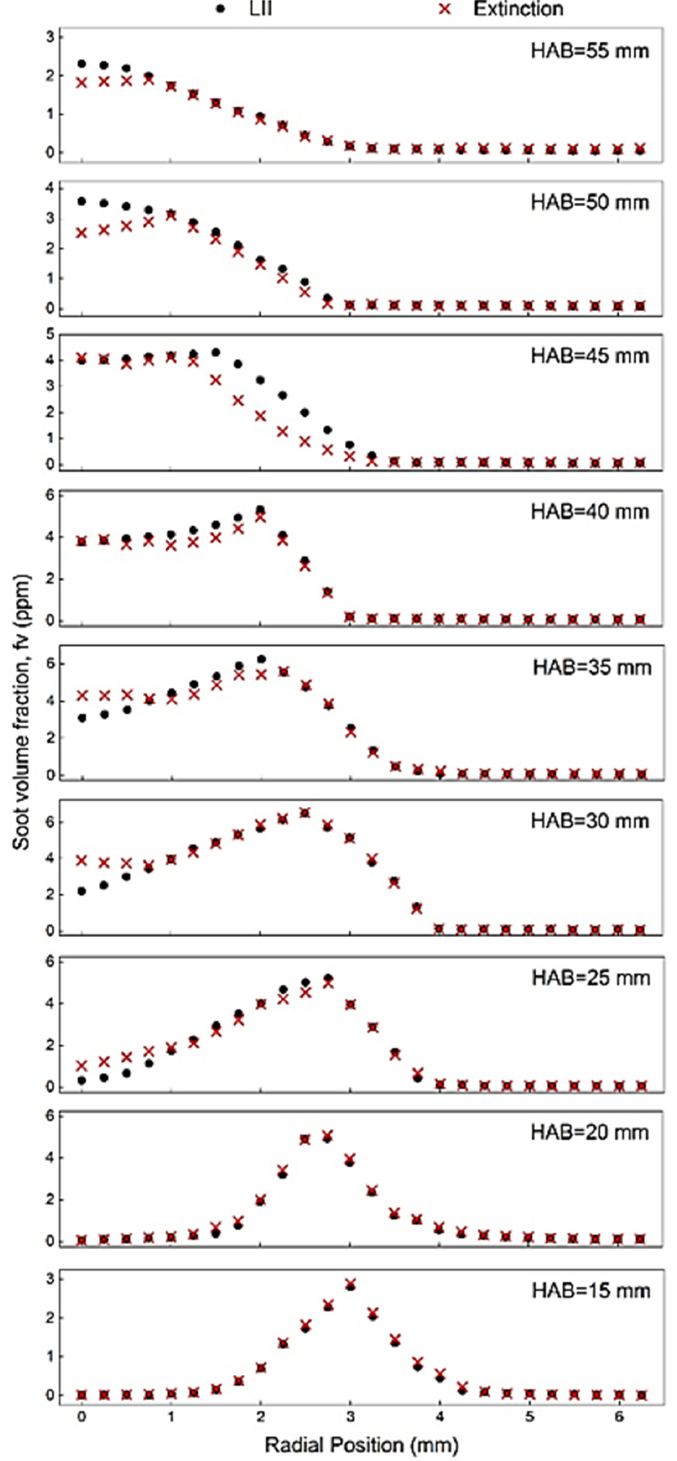
Figure 2. Comparison of the soot volume fraction of a standard ethylene diffusion jet flame at different heights above the burner measured by laser extinction and LII methods.